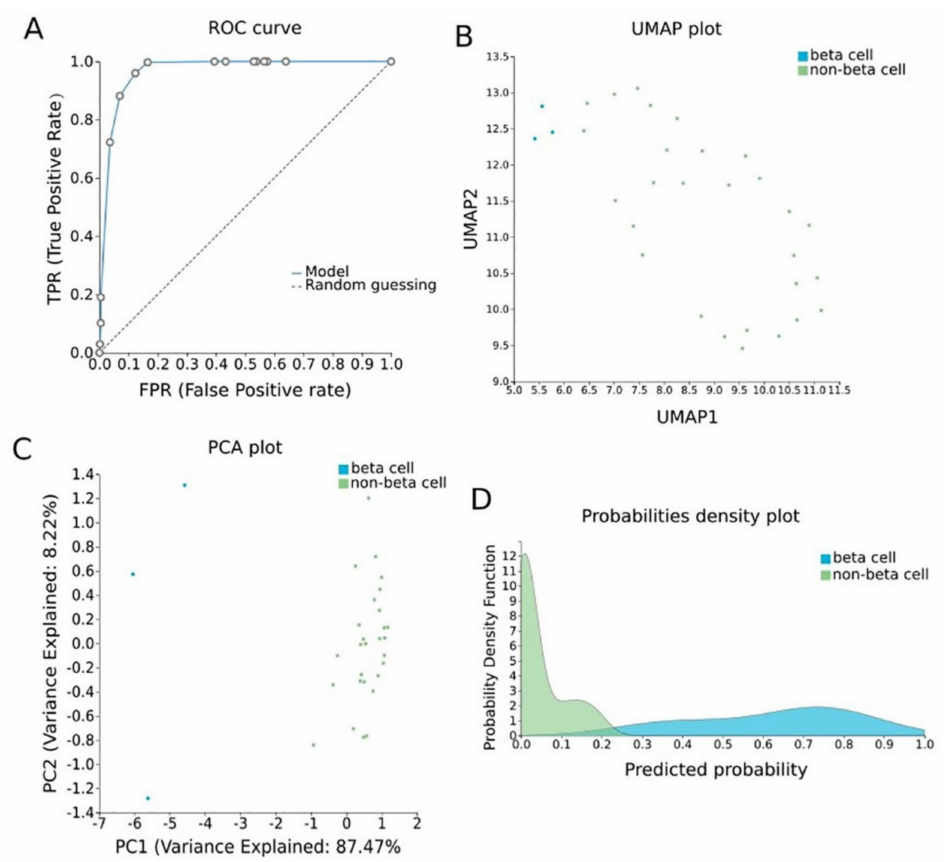
Figure 6. Pancreatic β -cell-specific methylation biosignature built using AutoML. ( A ) ROC curve of model. ( B ) UMAP plot shows separation between pancreatic β -cells (blue) and other tissues (green). ( C ) Supervised PCA plot (i.e., only considering the selected relevant biomarkers) presents separation between pancreatic β -cells (blue) and other tissues (green). ( D ) Out-of-sample proba- bility density plot (i.e., probability predictions when samples were not used for training) depicts discrete distributions among studied classes. Abbreviations: ROC = receiver operating characteristic, PCA = principal component analysis, UMAP = uniform manifold approximation and